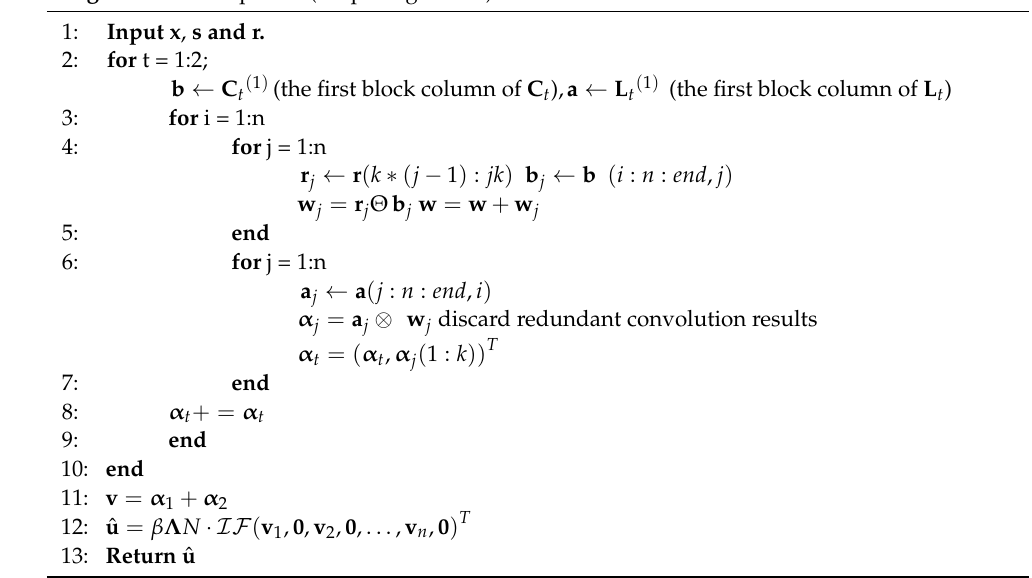
Algorithm 3 Compute ˆ u (Wxpet